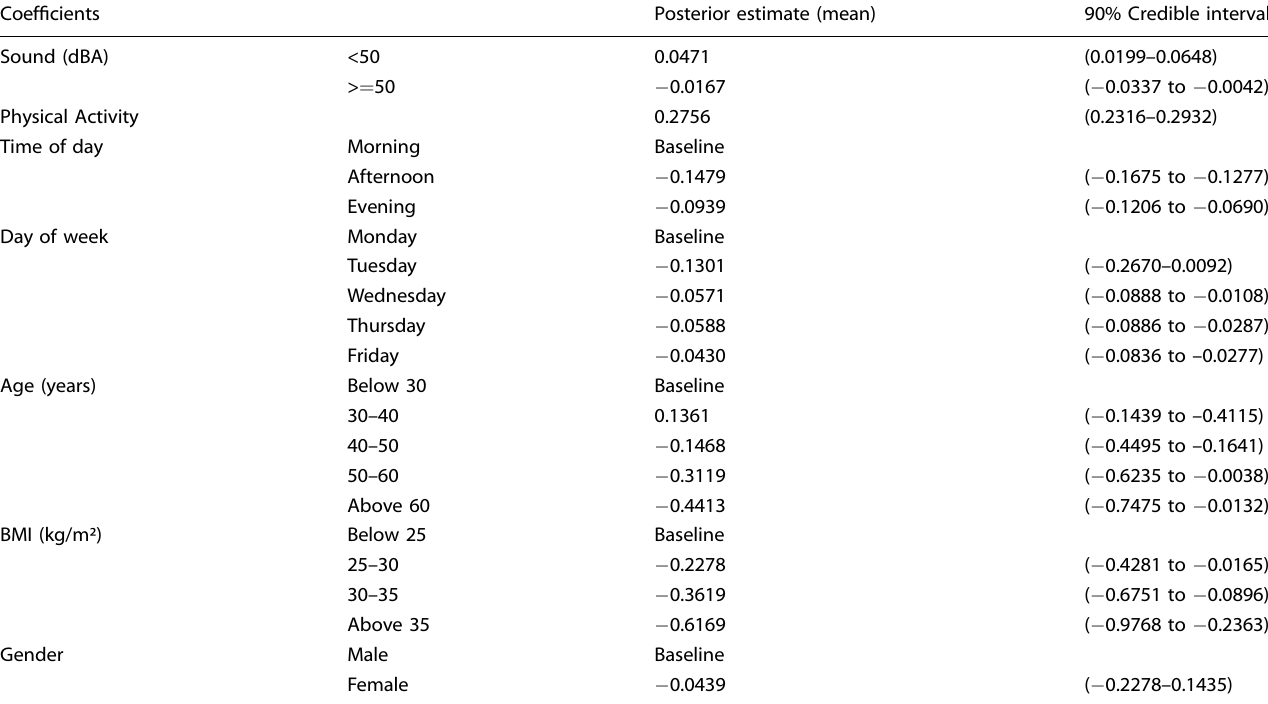
Table 1. Fixed effects of empirical Bayes